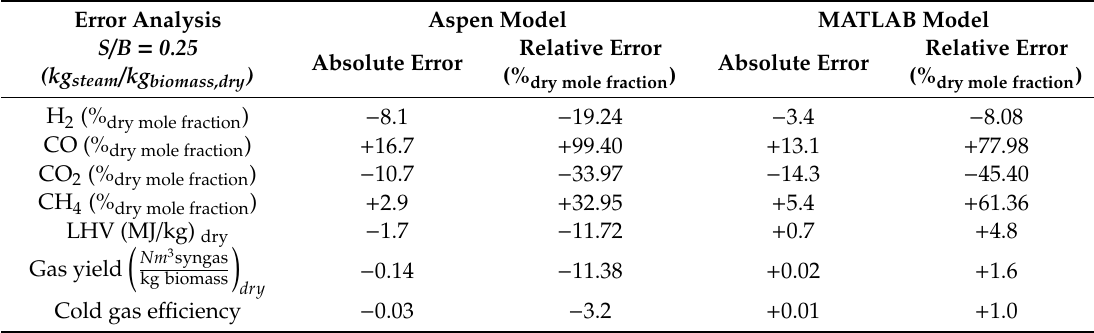
Table 5. Validation of syngas composition and characteristics (S / B = 0.25).